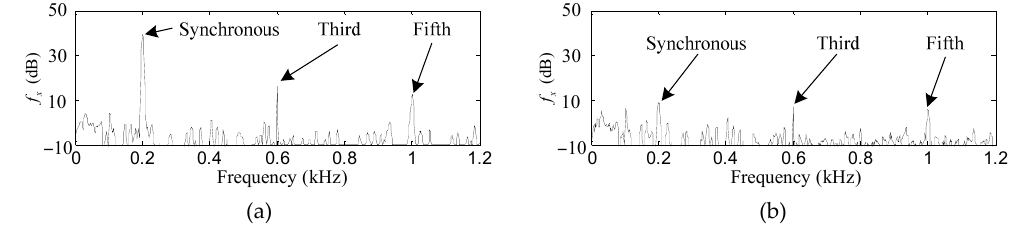
Figure 10. Experiment results of f x . ( a ) before harmonic force elimination; ( b ) after harmonic force elimination.